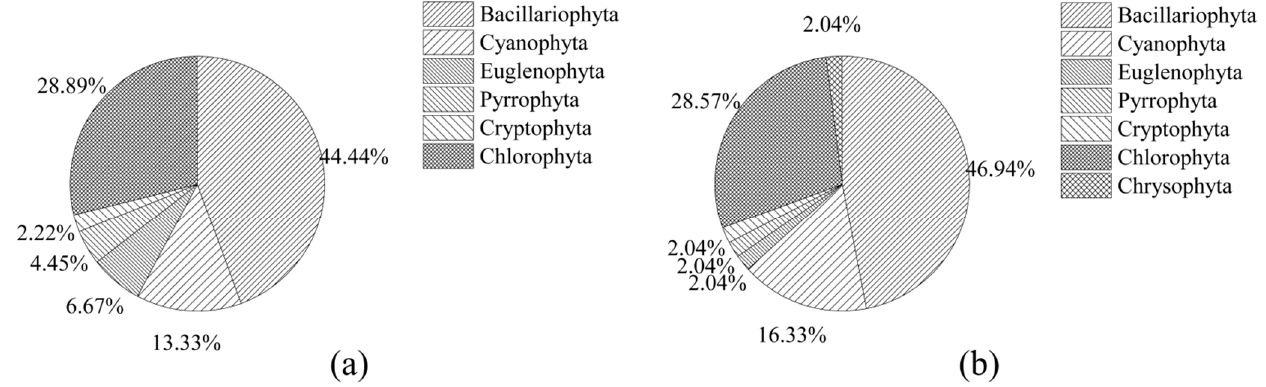
Figure 2. Community structure of periphytic algae during the wet season ( a ) and dry season ( b ).